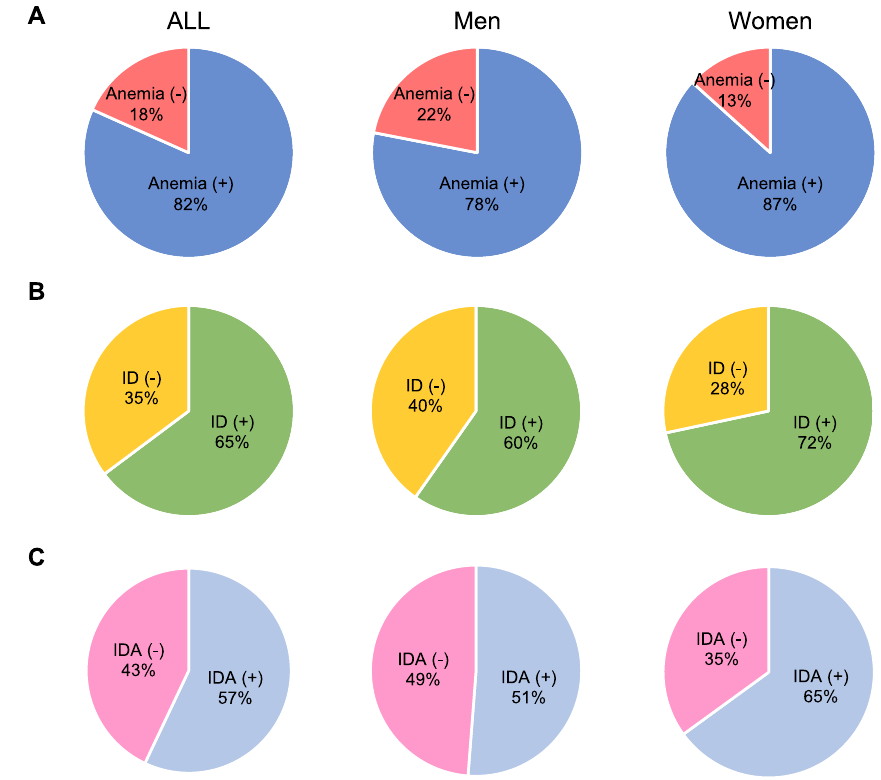
Figure 1. Prevalence rate of anemia, iron deficiency, and iron deficiency anemia in HF patients. Prevalence rate of ( A ) anemia, ( B ) ID, and ( C ) IDA in all HF patients. ID iron deficiency, IDA iron deficiency anemia.